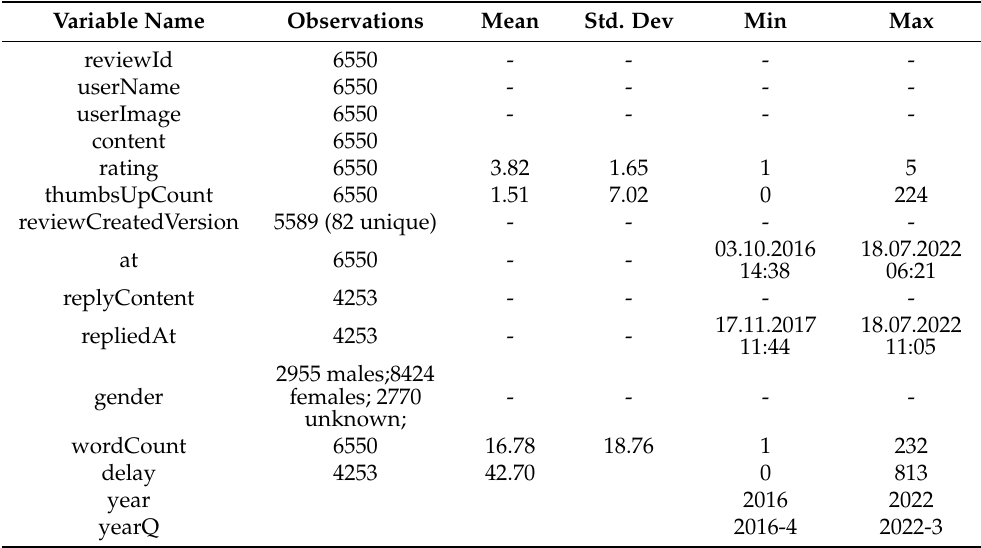
Table A1. Descriptive statistics of the